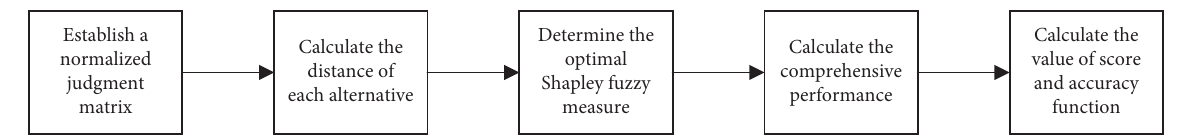
Figure 2: EVCS site selection decision diagram.